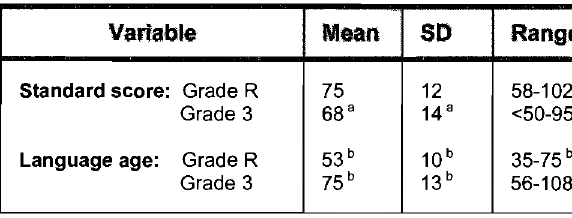
Table 1: Means, standard deviations and ranges of two meas­ ures of the Afrikaanse Reseptiewe Woordeskattoets (ARW)